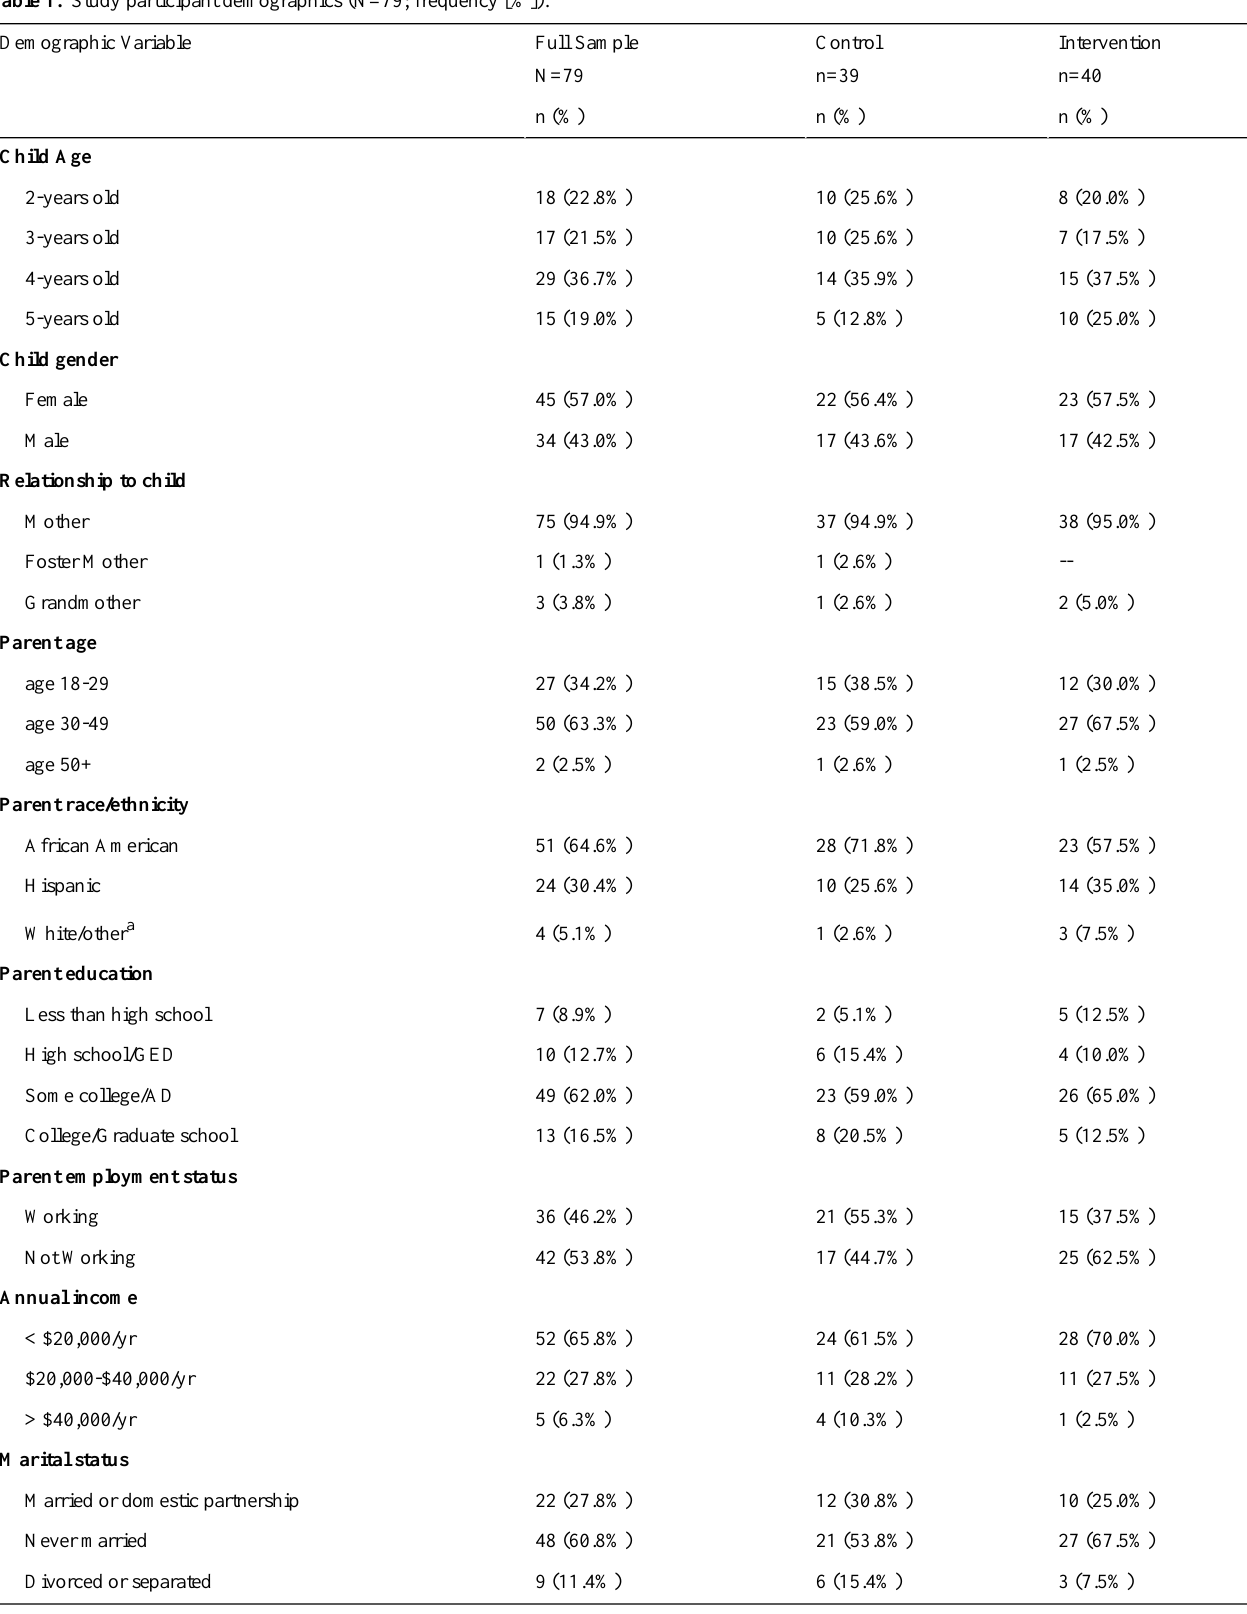
Table 1. Study participant demographics (N=79; frequency